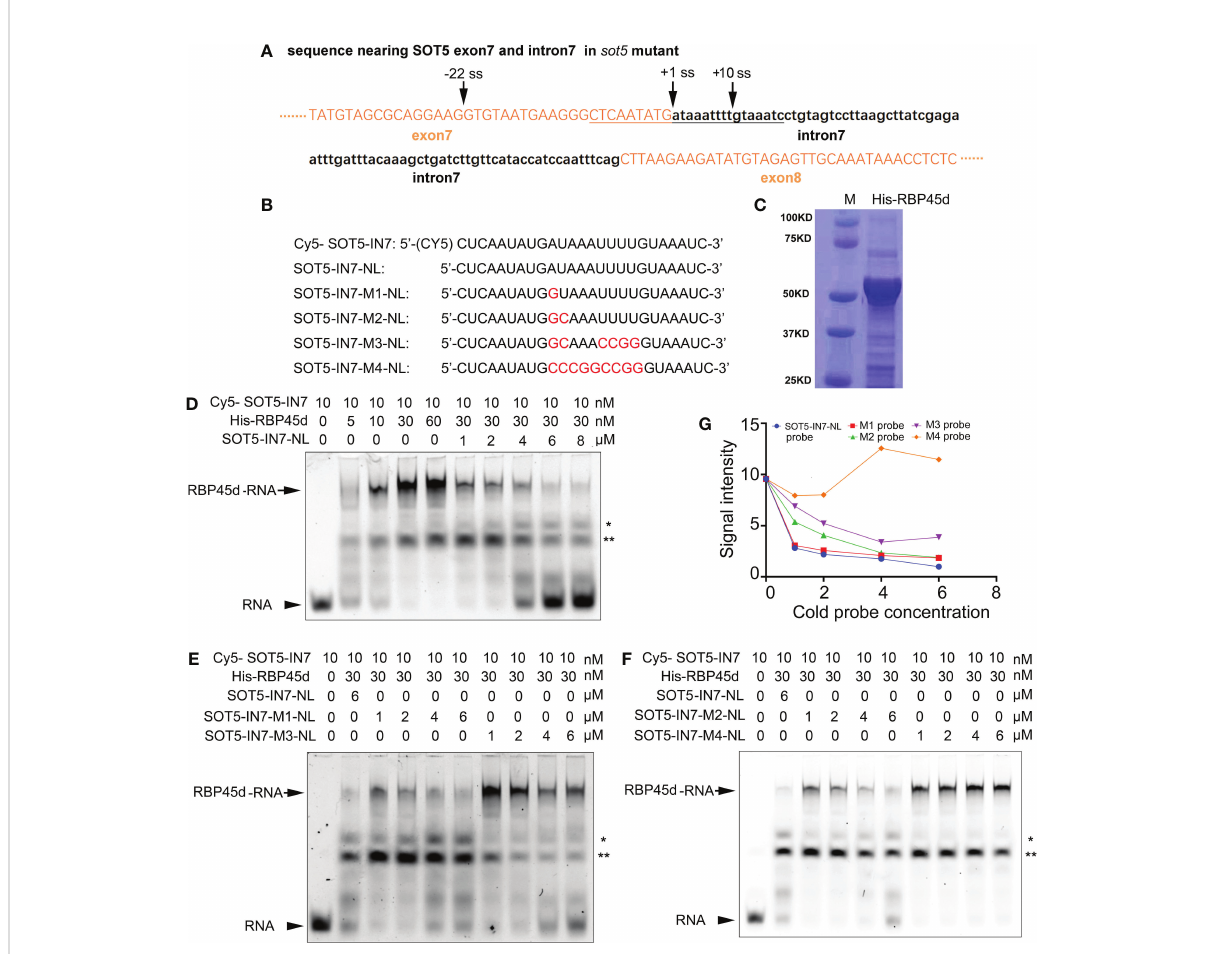
FIGURE 6 REMSA shows direct binding of RBP45d to the U-rich sequence downstream of the -22 ss of SOT5 intron 7. (A) DNA sequence nearby the cryptic 5 ’ splice sites in sot5 . Upper and lower case letters indicate exonic and intronic sequences in SOT5 gene, respectively. The underlined sequence is used as a template for RNA probe synthesis. Arrows, splice sites. (B) Probe names and sequences used for REMSA. The mutation sites in the probes were highlighted with red color. (C) Coomassie brilliant-blue staining of the puri fi ed His-RBP45d protein separated by SDS- PAGE. (D) RBP45d protein can directly bind to the Cy5-SOT5-IN7 RNA probe. (E) Competitive binding assay of unlabeled probes SOT5-IN7-M1- NL and SOT5-IN7-M3-NL with the labeled Cy5-SOT5-IN7 probe. (F) Competitive binding assay of unlabeled probes SOT5-IN7-M2-NL and SOT5-IN7-M4-NL with the labeled Cy5-SOT5-IN7 probe. Arrows in (D – F) show the protein-RNA complex. Arrowheads in (D – F) show the free RNA probe. * and ** in (D – F) indicate non-speci fi c bands. (G) Relative signal intensity of the protein-RNA complex in (D – F) was quanti fi ed by ImageJ software. The signal intensity of the protein-RNA band in the lane using 6 m M unlabeled SOT5-IN7-NL to compete with the labeled Cy5-SOT5-IN7 probe is arti fi cially set to 1 in (D – F) . For REMSA assays, three technical replicates were analyzed, and the results have the same trend. So one representative result is